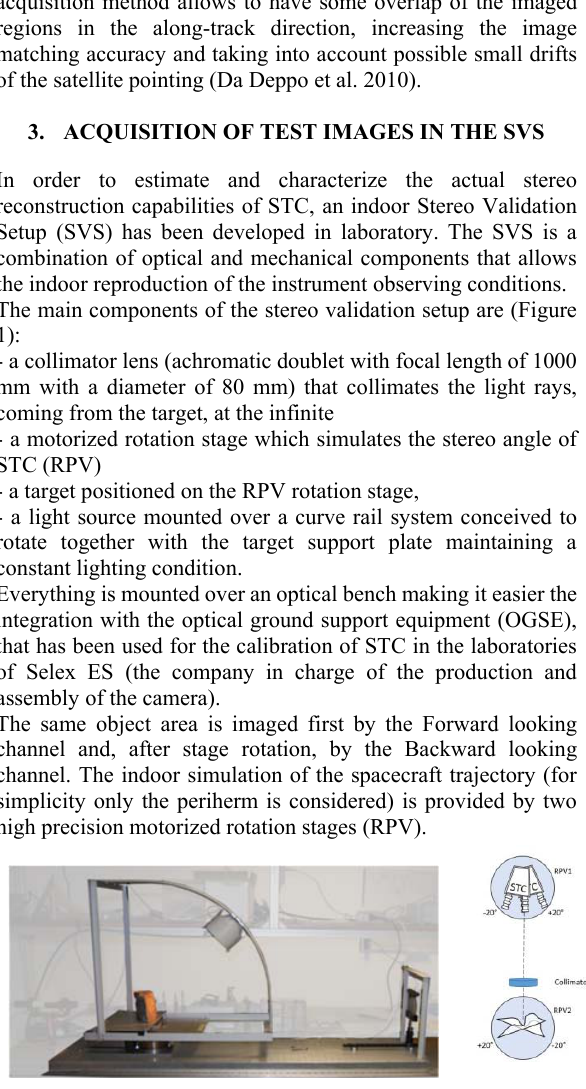
Figure 1: Left image: The SVS. The halogen lamp is mounted on the first rotational stage where the target sample is positioned. A collimator (on the right side) completes the optical system permitting the use of STC indoor. Right image: In laboratory simulation of STC observing with “Forward channel” and “Backward channel” at periherm by means of the SVS. Two RPV rotate the STC FM and the target.